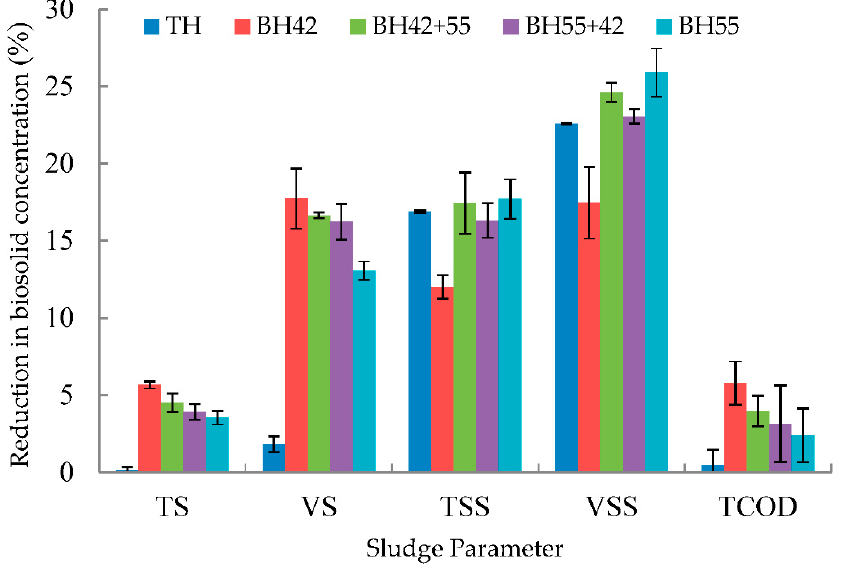
Figure 1. Reduction in biosolid concentration caused by thermal hydrolysis (TH) and biological hydrolysis (BH) treatments.